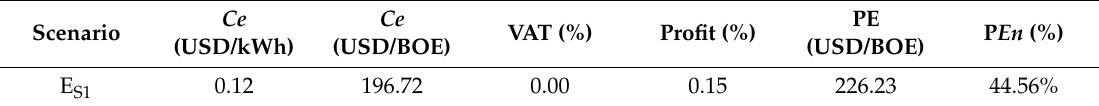
Table 13. The price of electricity from PVs.